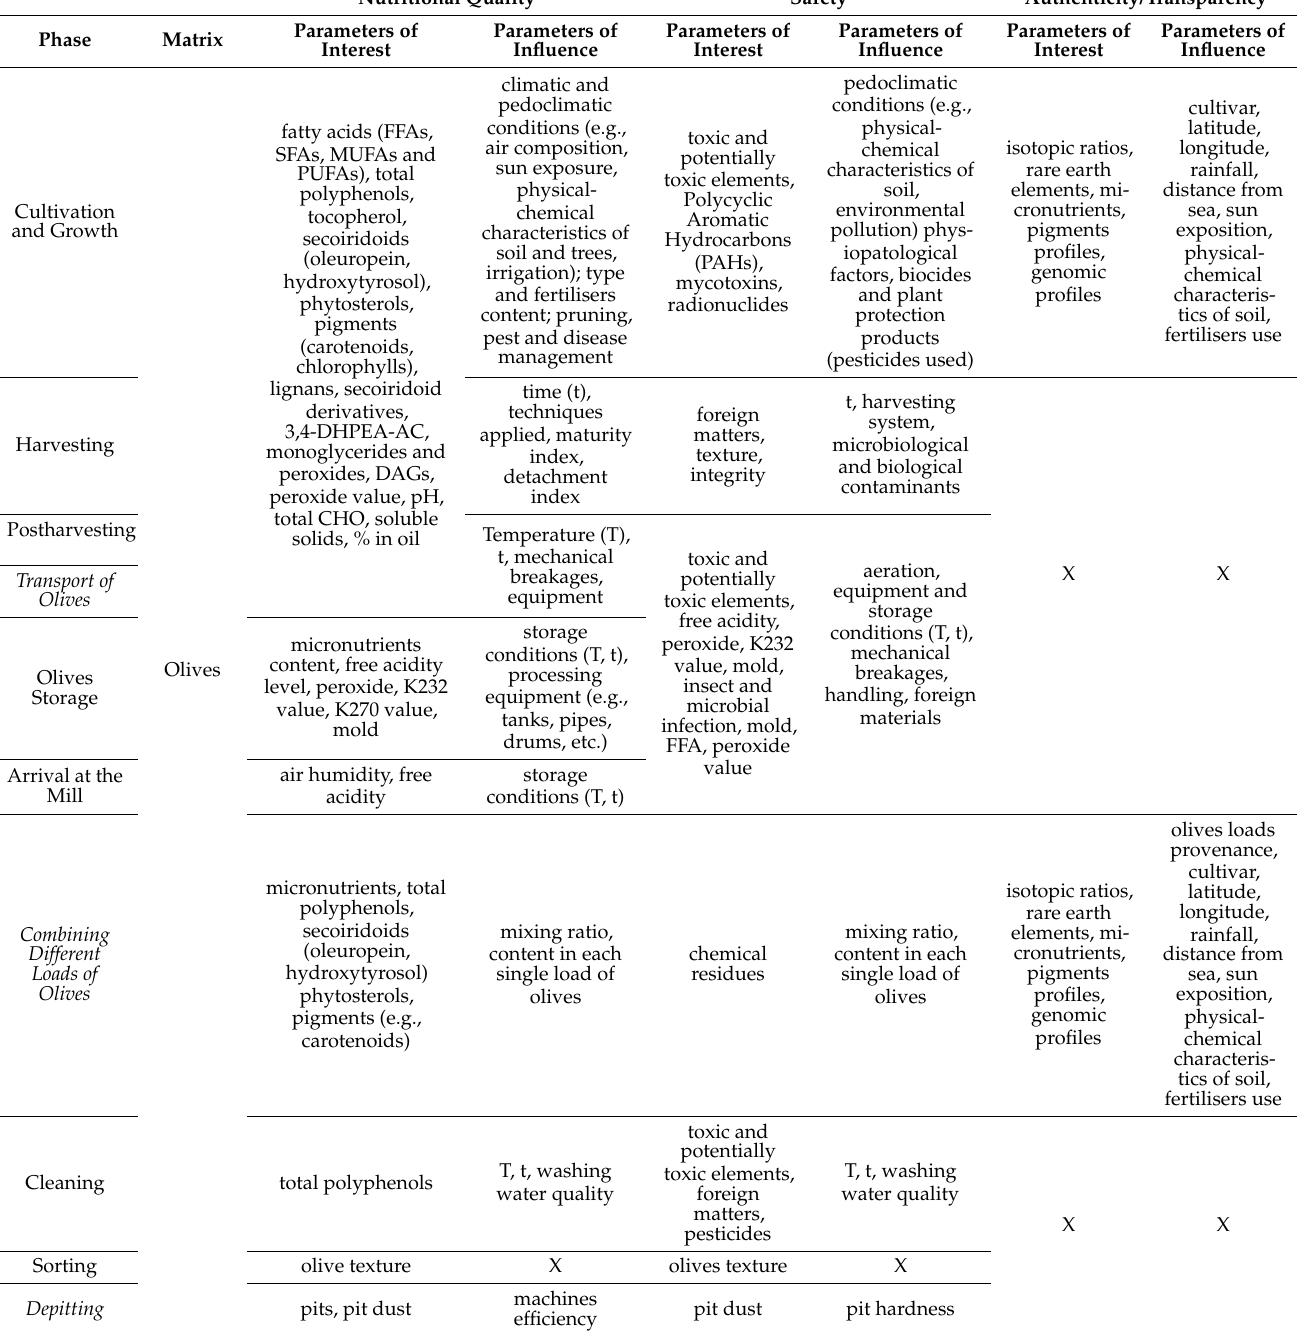
Table 2. Extract of the catalogue of parameters of interest and parameters of influence for nutritional quality, safety and authenticity/transparency concerning the virgin olive oil supply chain. The phases in italics are optional and at the choice of the food companies and “X” indicate that the process phase does not affect